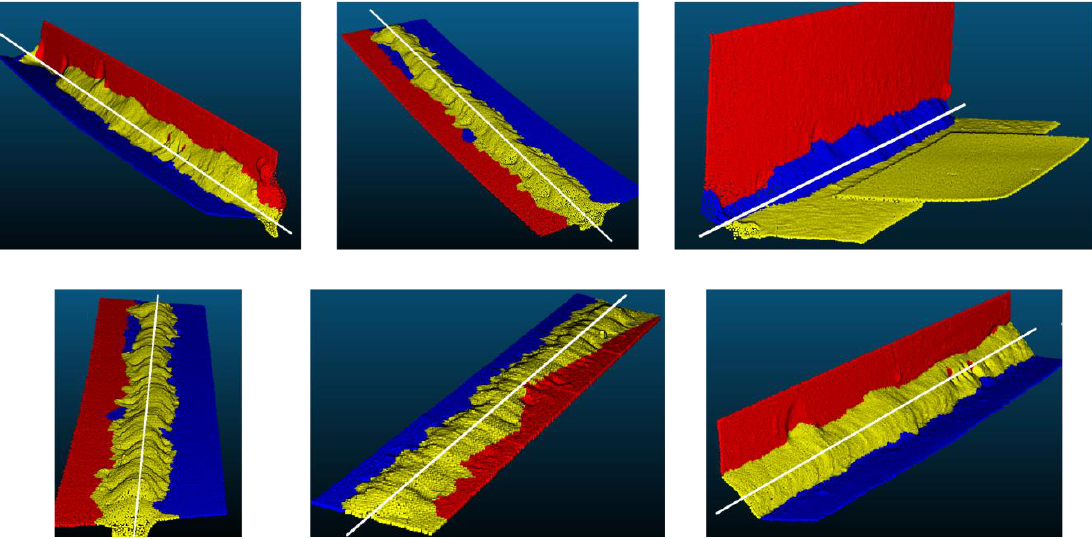
Figure 7. Sample of the semantic weld 3D models taking the plaques (red and blue), bead (yellow), and bead axis (white) as the main elements.